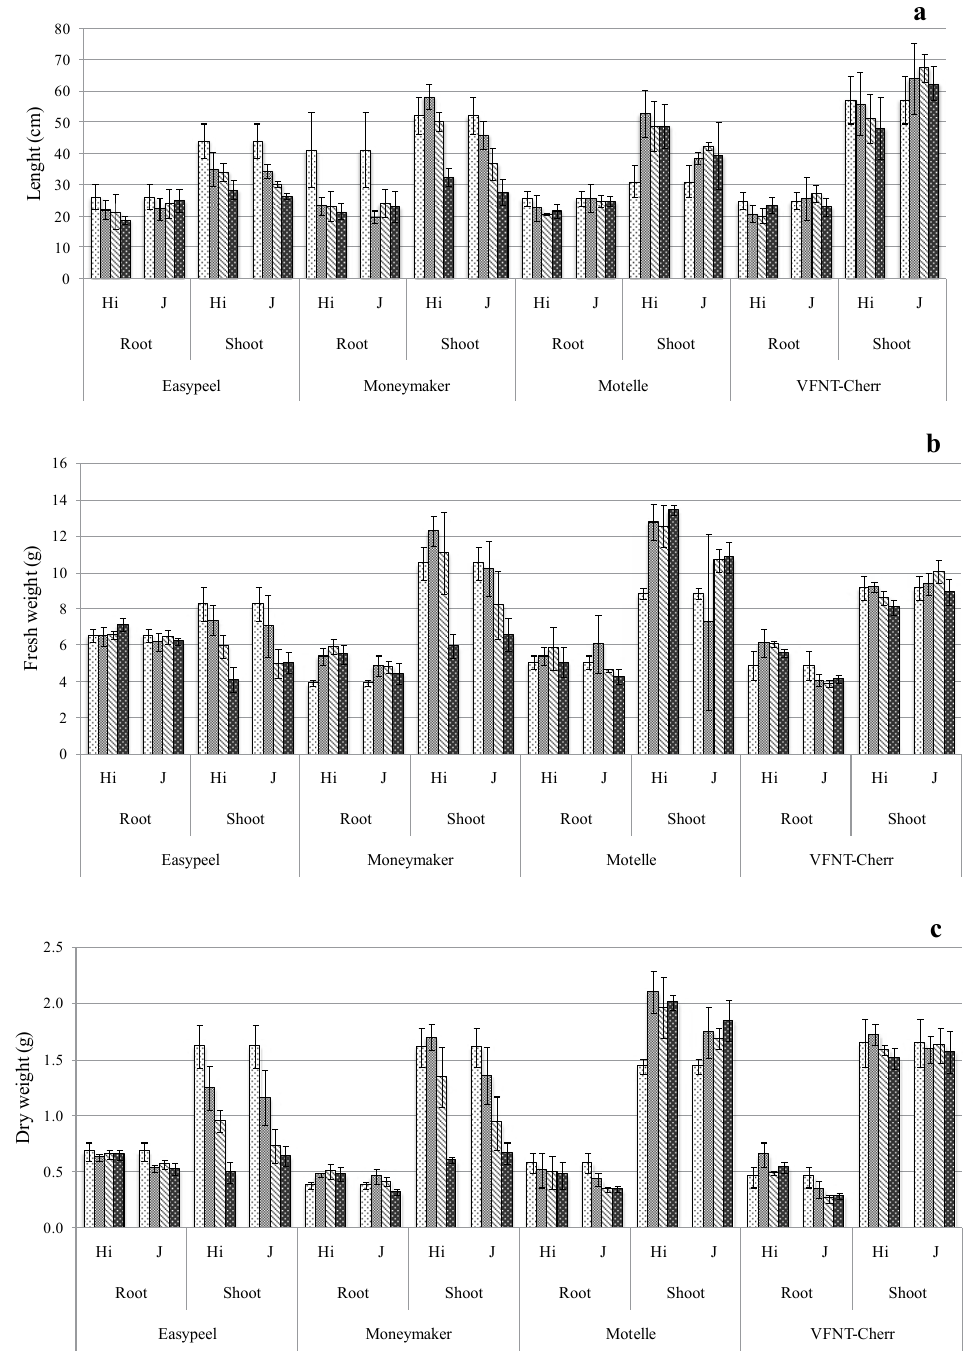
Figure 1. Effects of different initial inoculum levels ( 0, 2,500, 5,000 or 10,000 eggs/plant) of Meloidogyne hispanica (Hi) and M. javanica (J) on mean plant length (a) and fresh (b) and dry (c) weights, of tomato genotypes Easypeel, Moneymaker, Motelle and VFnt-Cherr. bars represent standard deviations. see Results section for data means on natural log (to base e ) scale for statistical